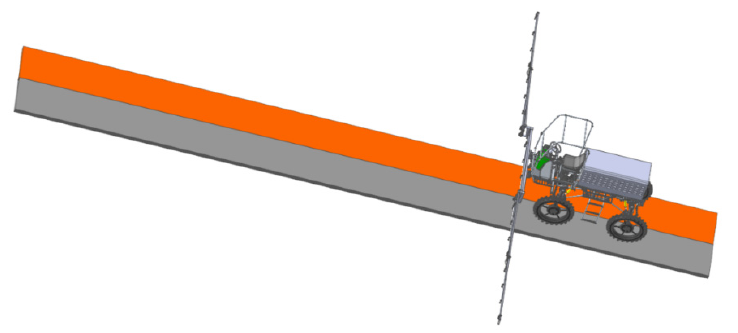
Figure 10. Simulation model of opposed pavement.